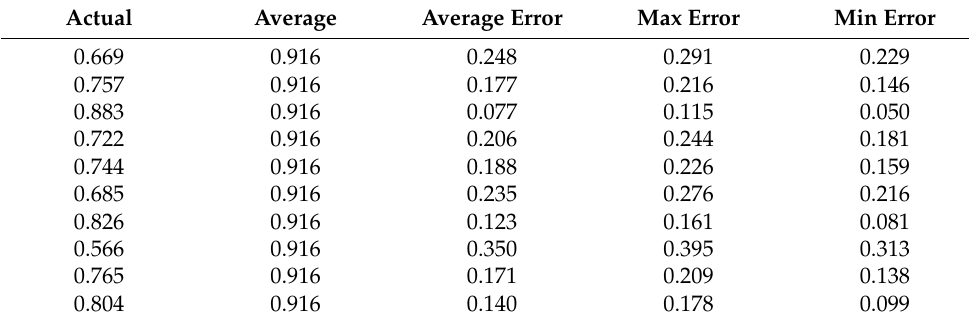
Table A175. Set 3, trials 11–20 data (average actual PR values).